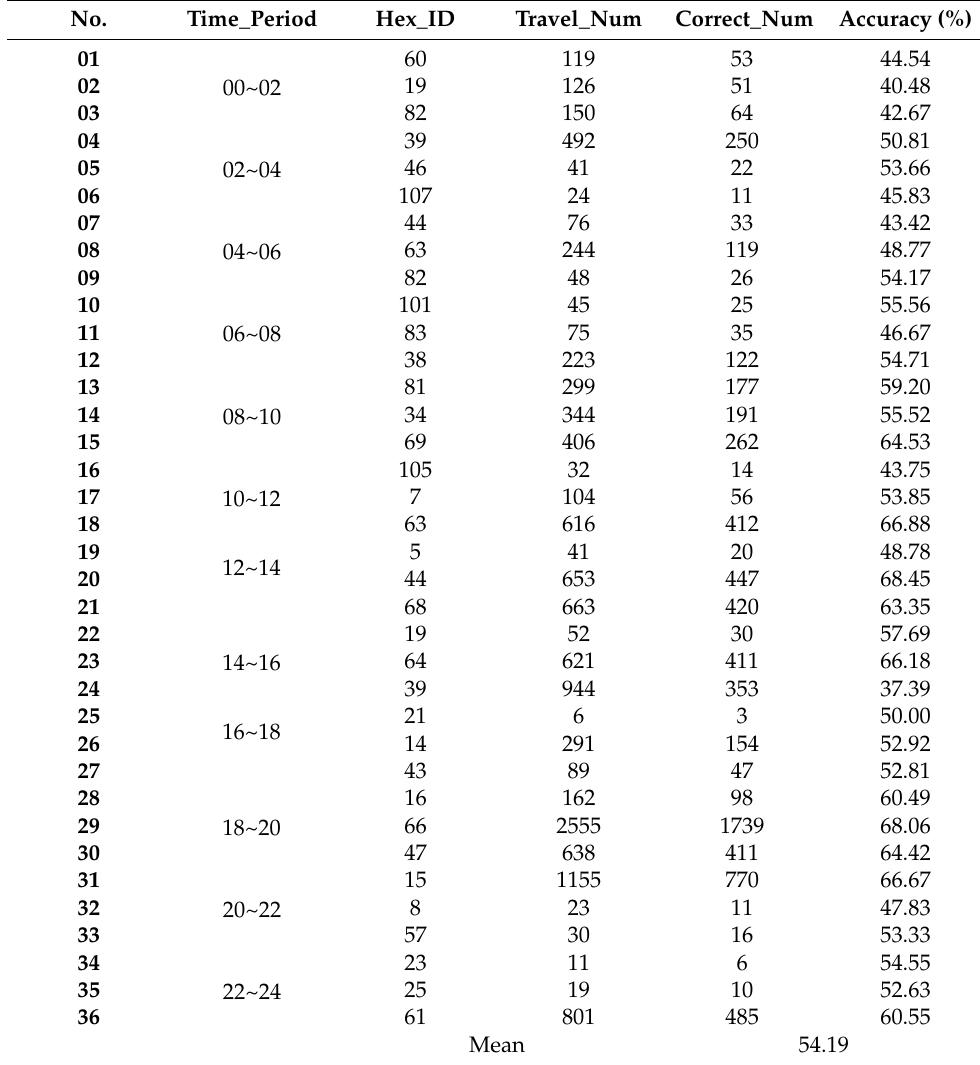
Figure 13. Pickup location ( left ) and the drop-off location ( right ) of 36 verification grids. Table 3. Comparison of prediction accuracies at Tl-STPM and real